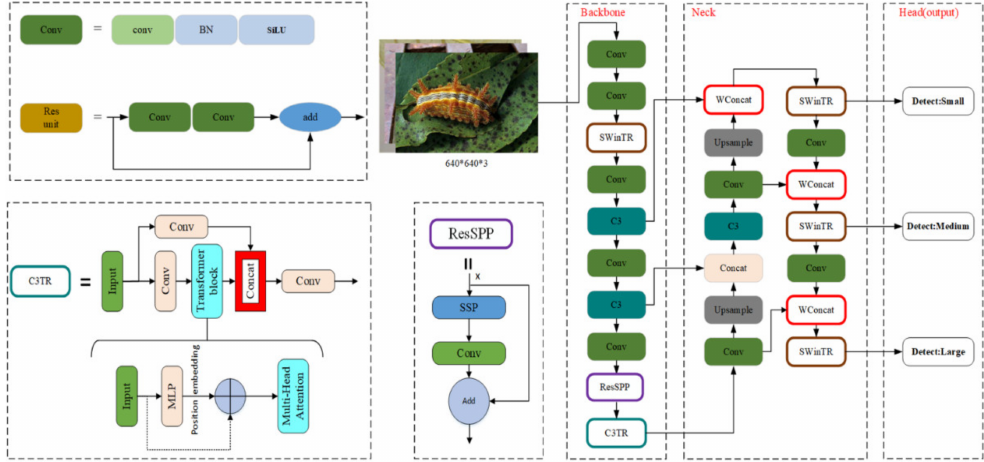
Figure 4. Improved YOLOv5m network structure. Backbone of the improved model includes Conv module, SWinTR module, ResSPP module, and C3TR module. SWinTR replaced C3 in the feature fusion part and added weights to the